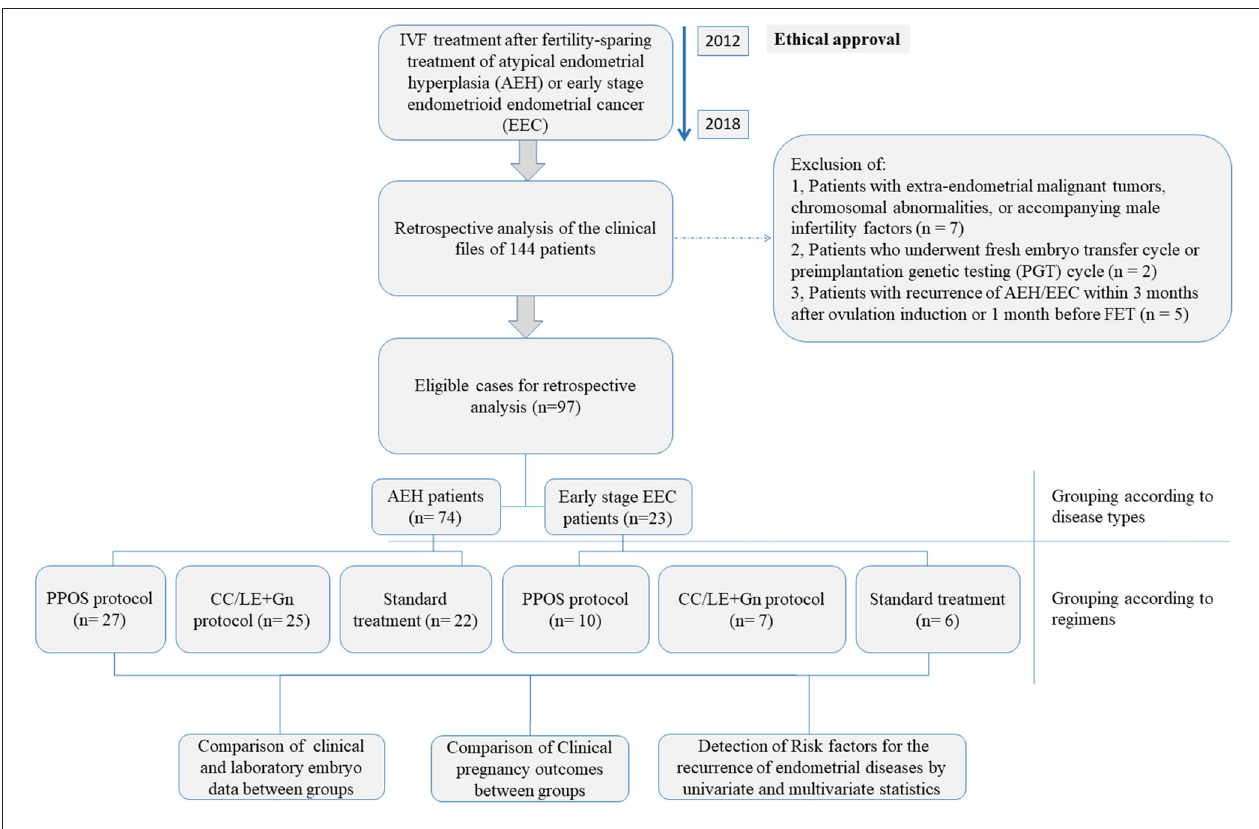
FIGURE 1 | Flowchart describing the design of the current retrospective